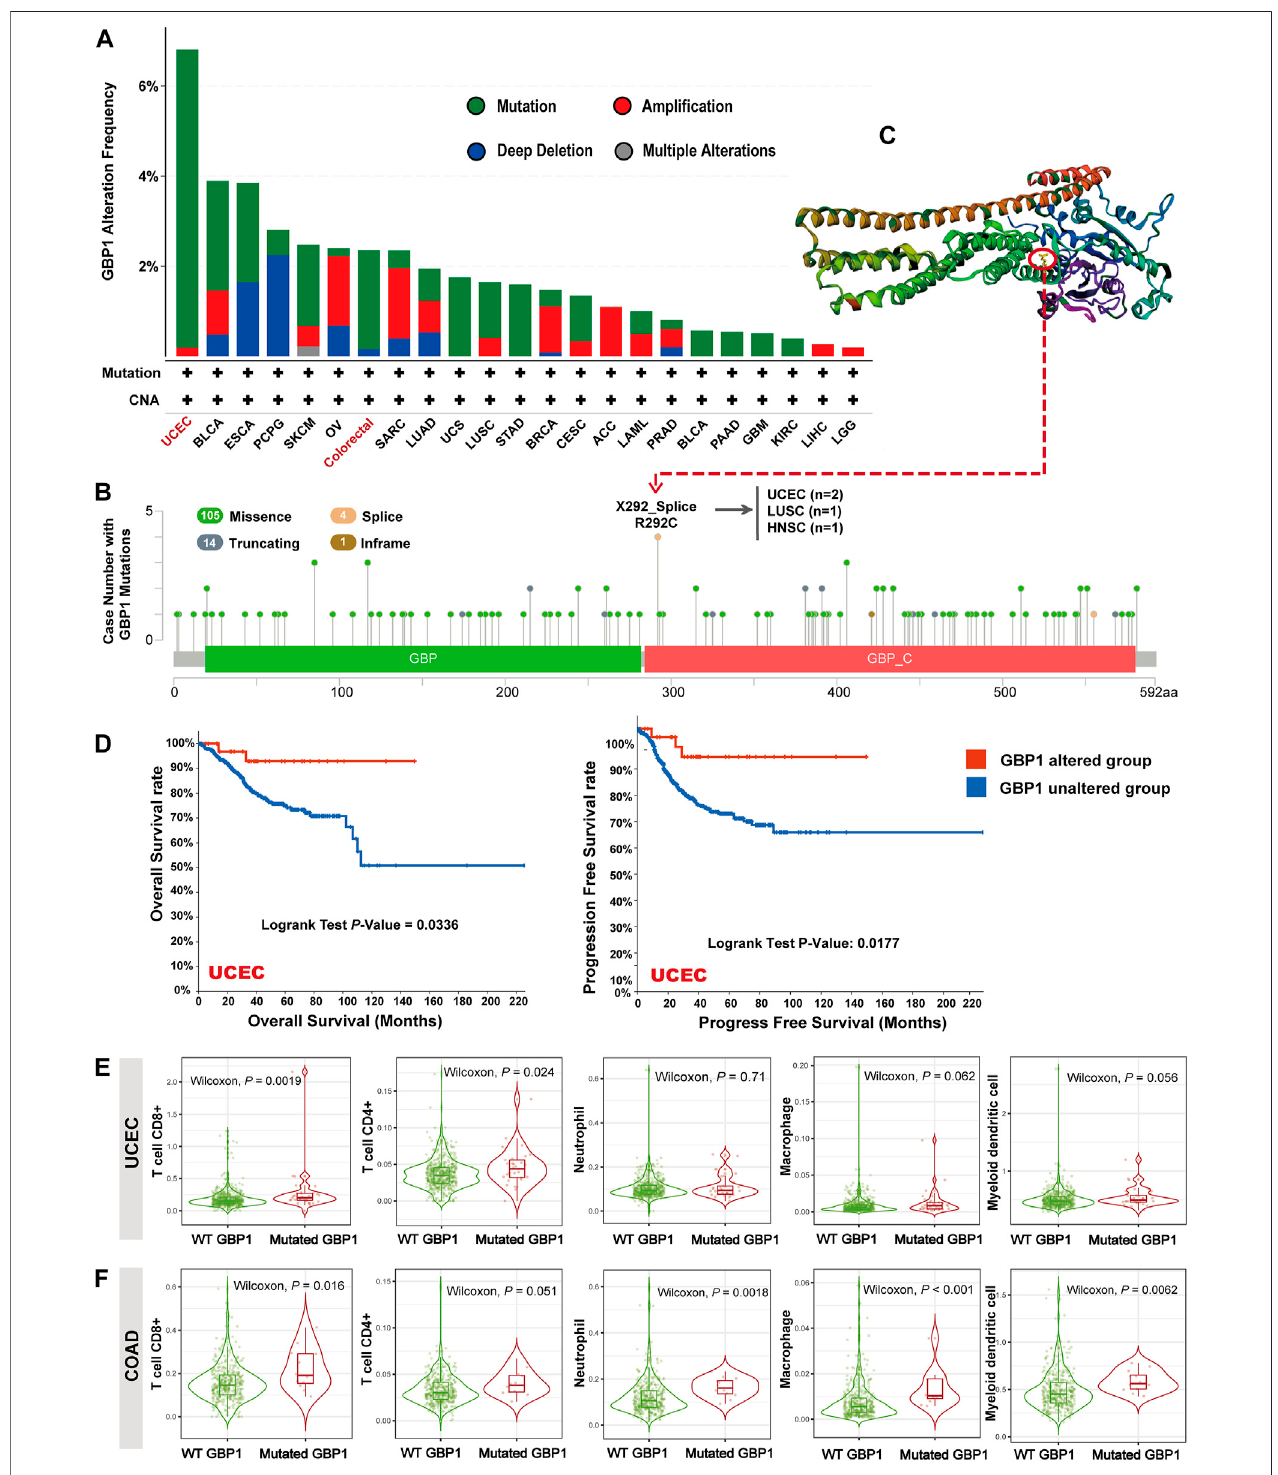
FIGURE3| GBP1alterationsindifferenttumorsofTCGA. (A) GBP1alterationfrequencywithmutationtypes. (B) GBP1mutationsite. (C) Themutationsitewiththe highest alteration frequency (X292_Splice/R292C) in the 3D structure of GBP1. (D) Kaplan – Meier curve for OS and PFS of UCEC patients with or without GBP1 alteration. The in fi ltration of CD8 + T cells, CD4 + T cells, neutrophils, macrophages, and myeloid dendritic cells between wild-type (WT) and mutated GBP1 groups of patients with UCEC (E) and COAD (F) .